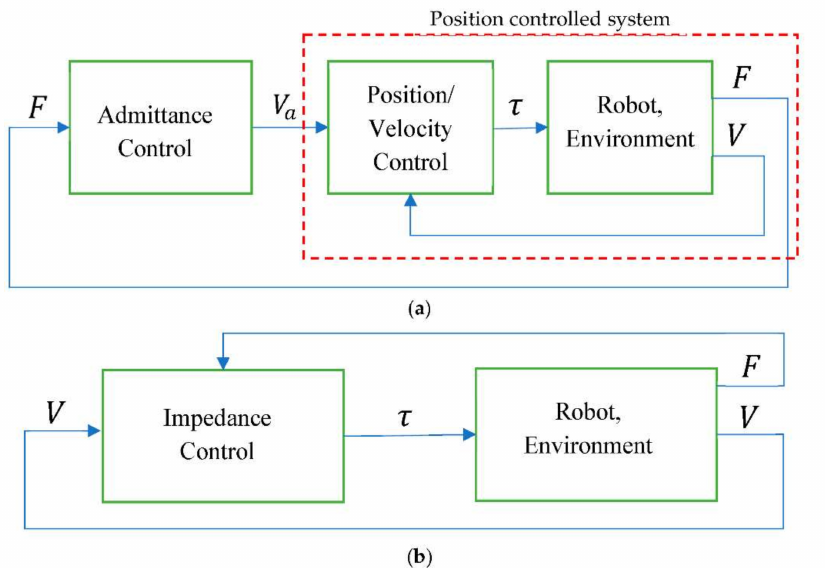
Figure 2. The concept or the implementation of the admittance and impedance controller ( a ) Admit- tance Control and ( b ) Impedance